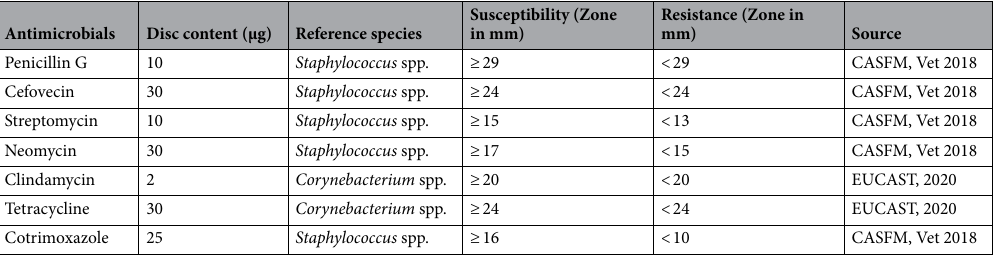
Table 6. Interpretation breakpoint table of zone diameters a used for susceptibility evaluation of Gordonia species isolates. a Disc diffusion